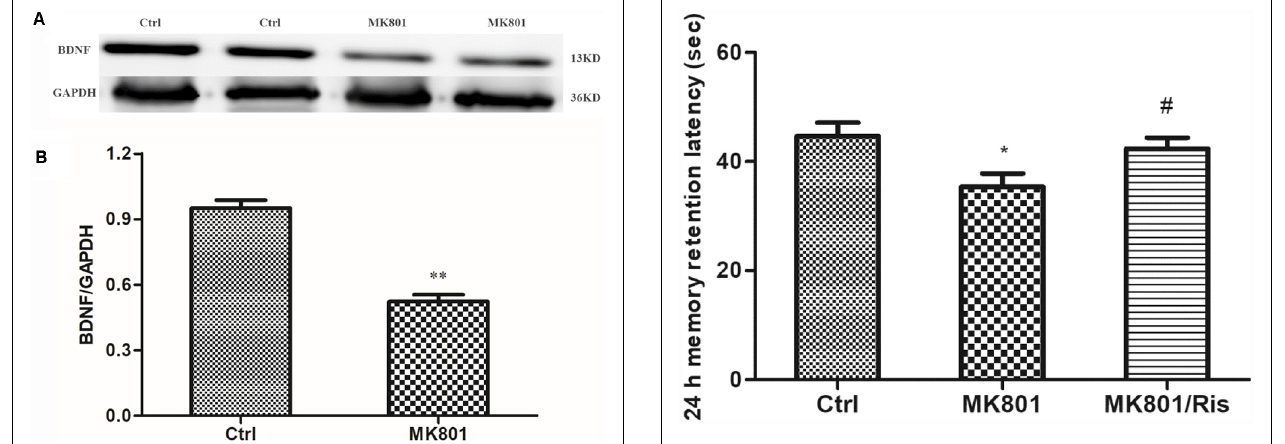
FIGURE 4 | Western blot analysis of BDNF protein level in the hippocampus of MK-801-treated rats. MK-801 was administered daily by injection (0.5 mg/kg body weight, i.p.) for 6 days. Control animals received an equal volume of normal saline. (A) BDNF protein expression was detected by western blot analysis of hippocampal lysates from MK-801-treated (MK801) and control (Ctrl) rats ( n = 4 per group). (B) Densitometric values are expressed as mean ± SEM relative to the loading control. Statistical differences between two groups were evaluated with the Student’s t -test. ∗∗ P < 0.01 vs. control group.